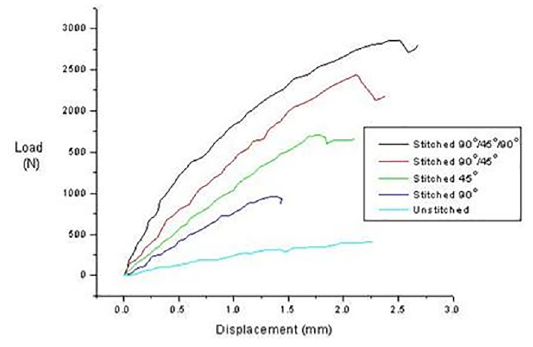
Figure 10. Core shear test results. Table 1. Average shear strength and shear modulus (standard deviation in parenthesis) Sl